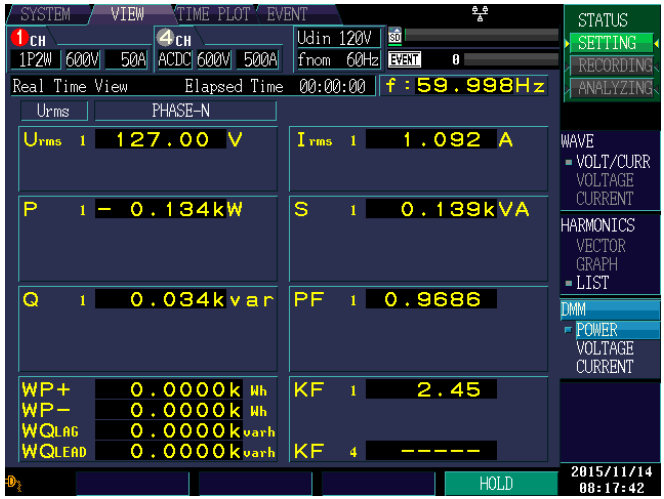
Figure 17. PF obtained in experimental tests of the power quality meter.